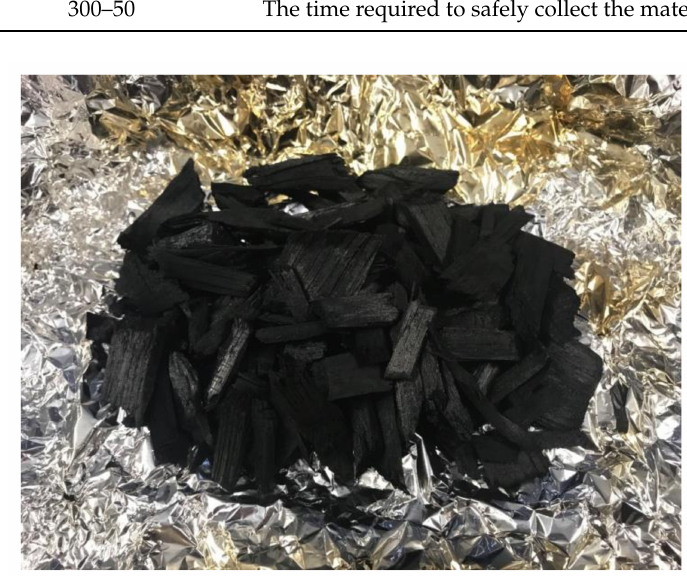
Figure 3. Example of one of the obtained materials, in this case torrefied pine